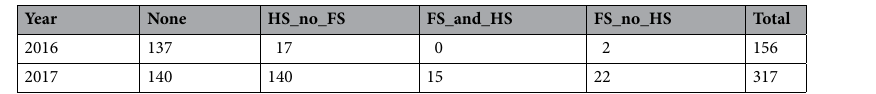
Table 2. Number of sampled larvae with and without half-sibs (HS) or full-sibs (FS).